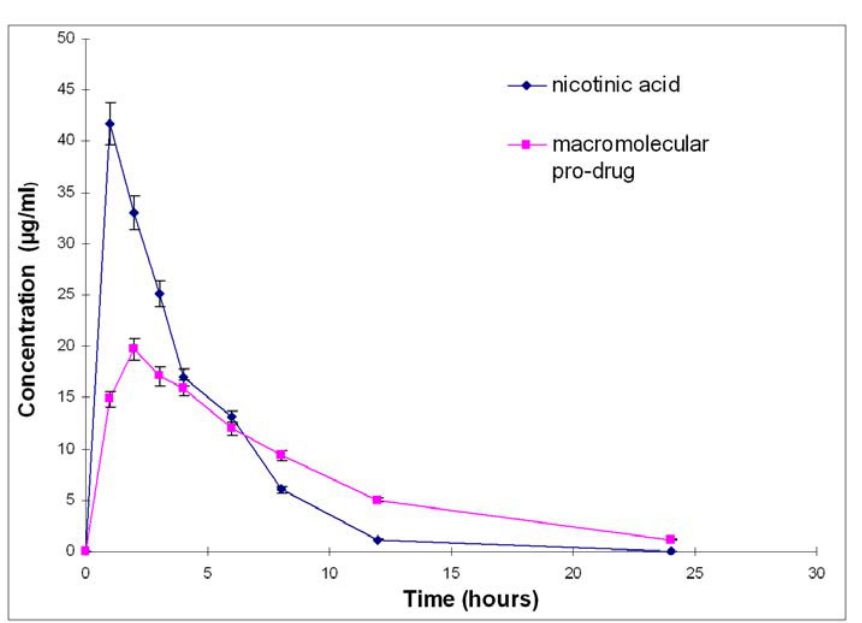
Fig. 2 Time course of nicotinic acid levels in plasma after administration of free nicotinic acid (– (cid:2) –) and the macromolecular pro-drug in rats (– (cid:3) –) The shape of the elimination curve indicates that, for free nicotinic acid (Group I), the maximum plasma concentration (C max ) is reached 1 h after administration (Fig.